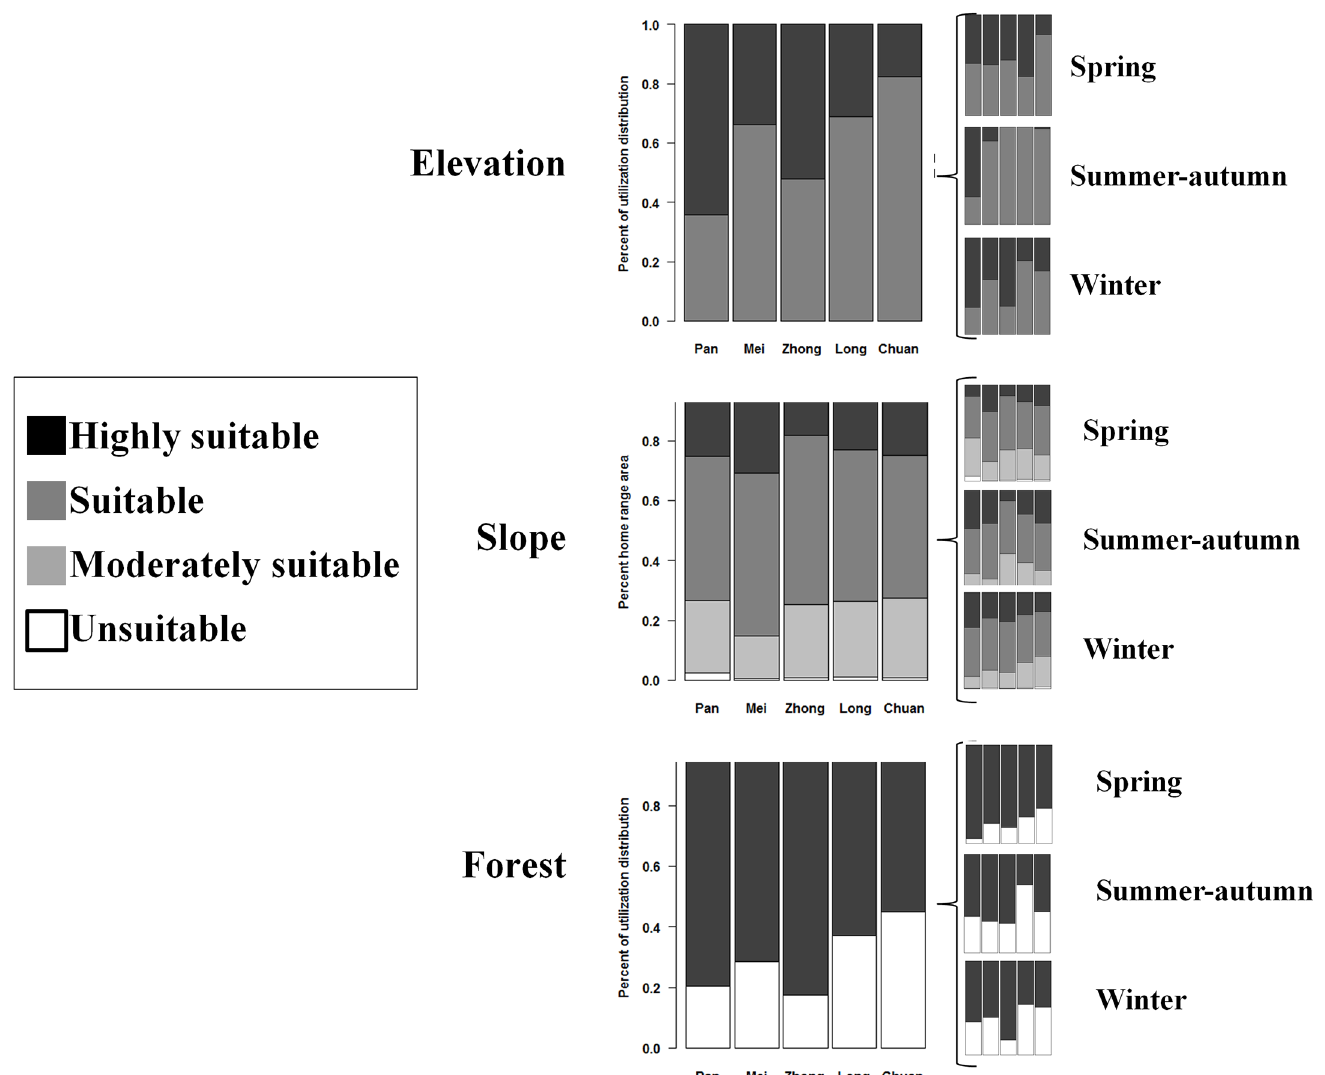
Fig 4. Proportion of GPS-collared panda's utilization distributions in different habitat suitability classes for (a) elevation, (b) forest, and (c) slope. Classes were derived from Liu et al. (1999). Mid-elevations, forest, and gentle sloped areas have higher suitability. The main plots are the entire year and sub-plots on the right are broken down by